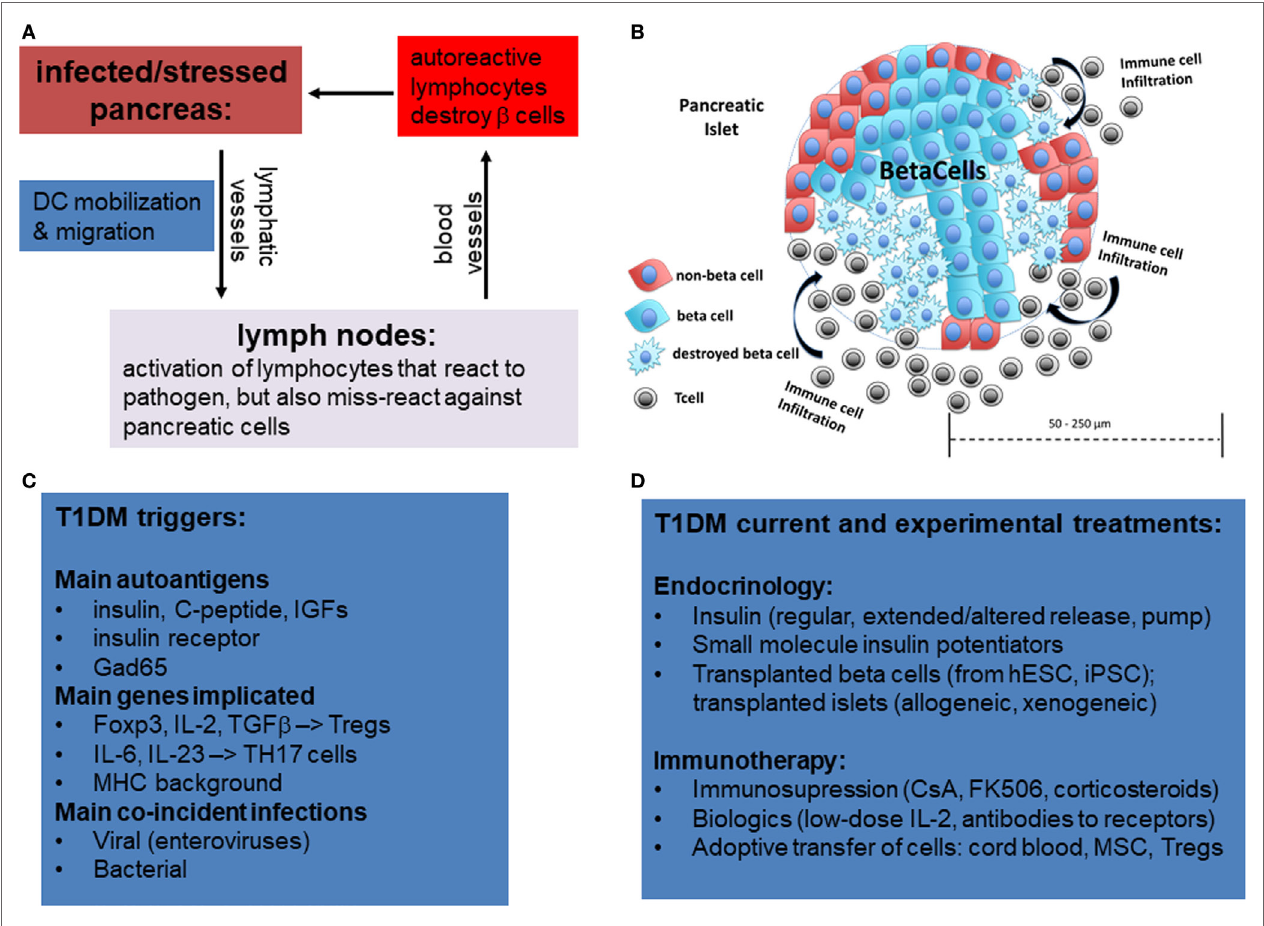
FigURe 1 | Overview of mechanisms of etiology of type 1 diabetes by miss-guided autoreactive adaptive immune response following infection, major stress, or trauma to the pancreas. (A) Following bacterial or viral infections or trauma in the pancreas, dendritic cells (DCs) are activated. While DCs normally only present on their MHCI and MHCII antigens from pathogens, in rare circumstances DCs also activate T lymphocytes that have some affinity for autoantigens, a phenomenon referred to as “molecular mimicry.” Acute destruction of endocrine pancreatic cells, especially β -cells, can then give rise to type 1 diabetes mellitus (T1DM). (B) Representative diagram showing infiltration of pancreatic islets by immune cells and partial islet destruction. (C) The main postulated triggers of T1DM include autoantigens, certain mutations in genes activating regulatory T-cells or Th17 cells, and viral and bacterial infections. (D) Overview of current and experimental approaches using immune and stem cells to treat